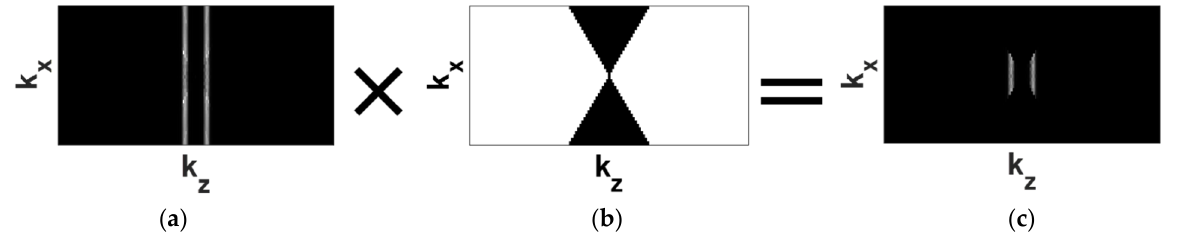
Figure 5. Spatial filtering of recorded time traces, which removes waves travelling at higher angles; ( a ) original signal after 2D FFT, ( b ) spatial frequency mask removing waves at angles larger than 𝛼 (cid:3030)(cid:3033) and ( c ) Fourier domain signal after